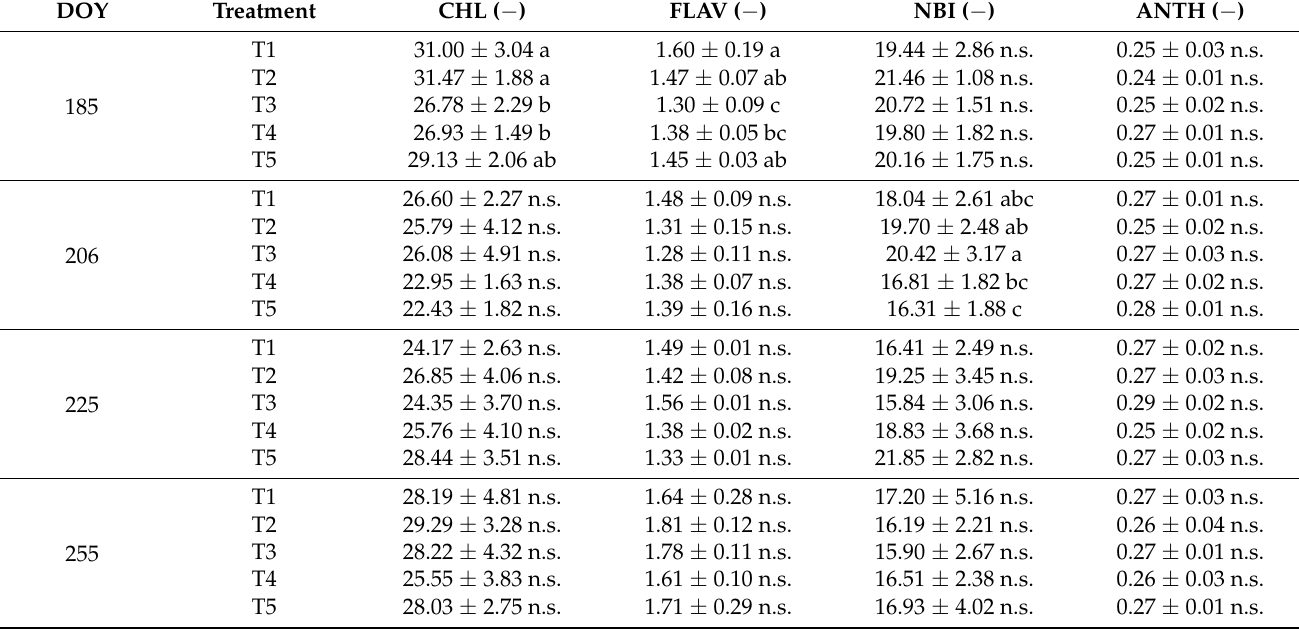
Table 5. Effects of substrates with different compost ratios (0–10–20–40%) on chlorophyll (CHL), flavonoids (FLA) and anthocyanins (ANTH) content, and nitrogen balance index (NBI) at different times during the growing season. Means followed by the same letter do not significantly differ at p < 0.05. DOY = day of year. Data are reported as mean values ( n = 12) ± SD, n.s. = not significant.